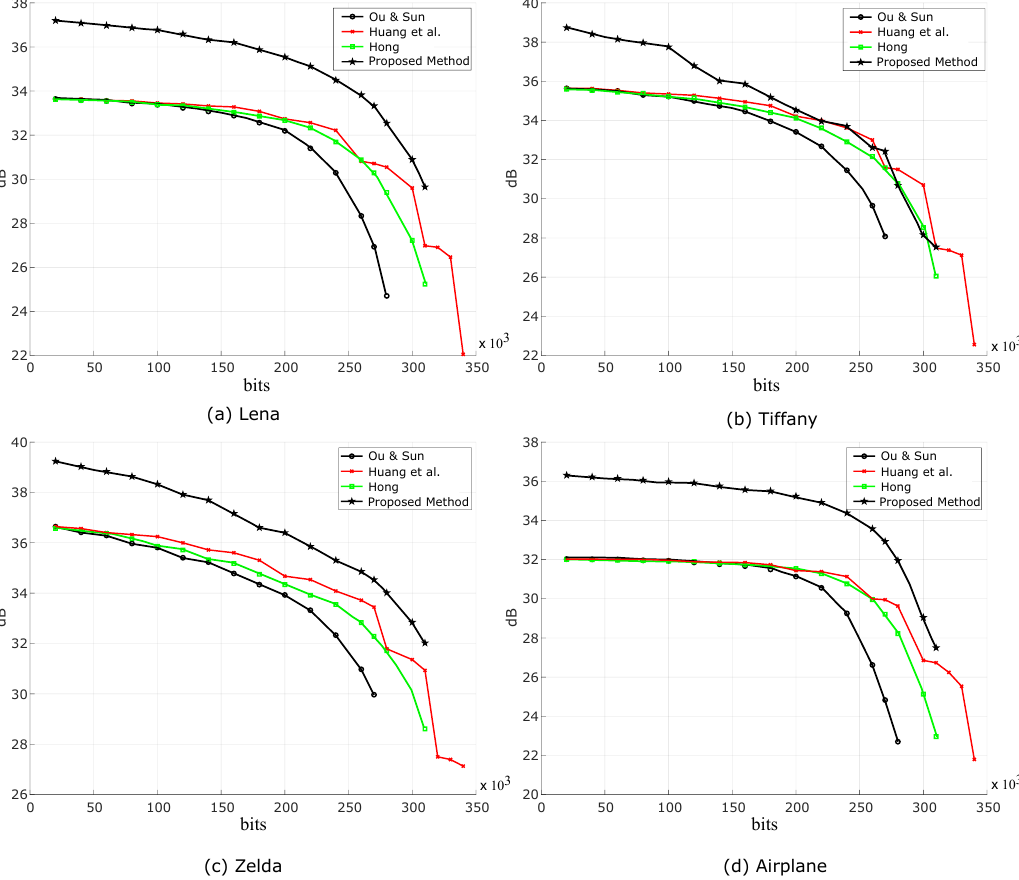
Figure 5. Performance comparisons of the proposed method and other related methods (i.e., Ou and Sun [19], Huang et al. [20], and Hong [21]) based on AMBTC and ABTC-EQ compressed image for four typical images: ( a ) Lena, ( b ) Tiffany, ( c ) Zelda, and ( d )